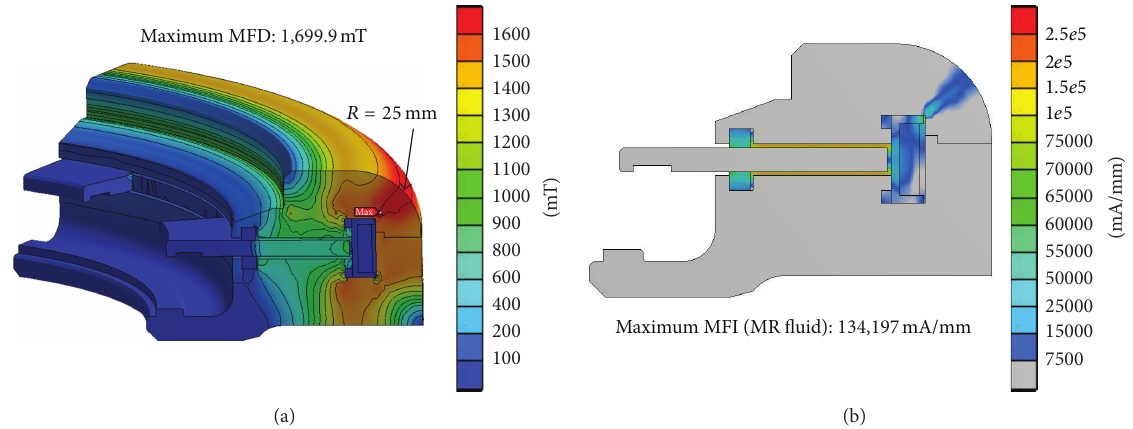
Figure 7: FEA results of the rotary MR damper (Model B, 𝑅 = 25 mm). (a) Magnetic flux density (MFD). (b) Magnetic field intensity (MFI).